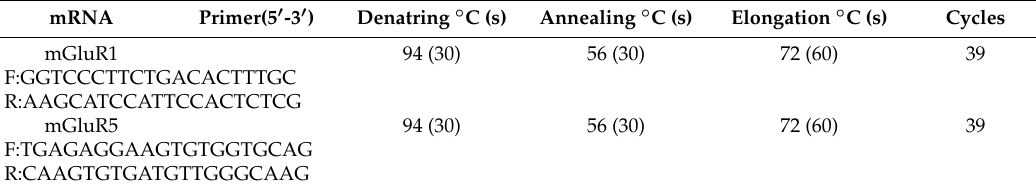
Table 1. Primer sequences and PCR conditions. All templates were initially denatured for 3 min at 94 ◦ C, and after completing all cycles, were extended a final extension of 5 min at 72 ◦